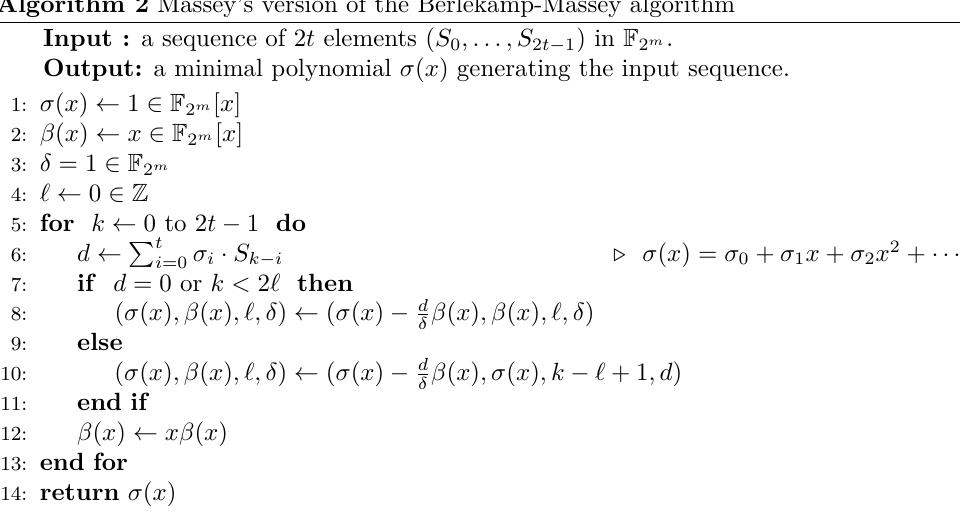
Algorithm 2 Massey’s version of the Berlekamp-Massey